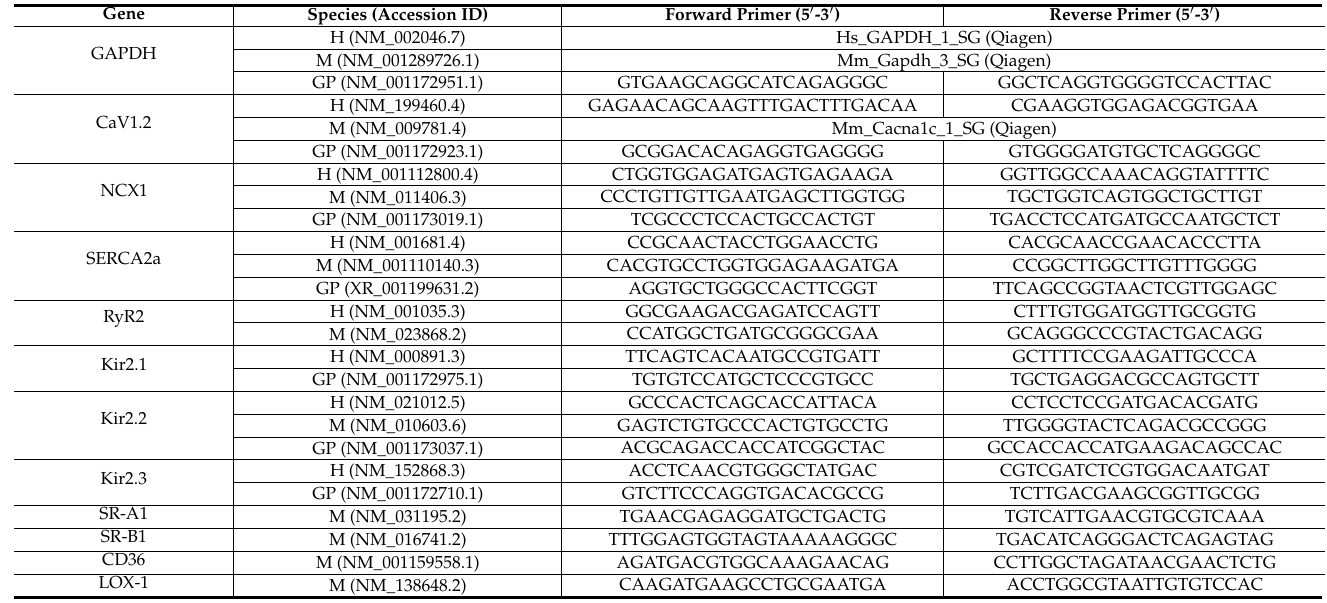
Table 1. Sequences of the primers used for qPCR. H-human; M-mouse; GP-guinea